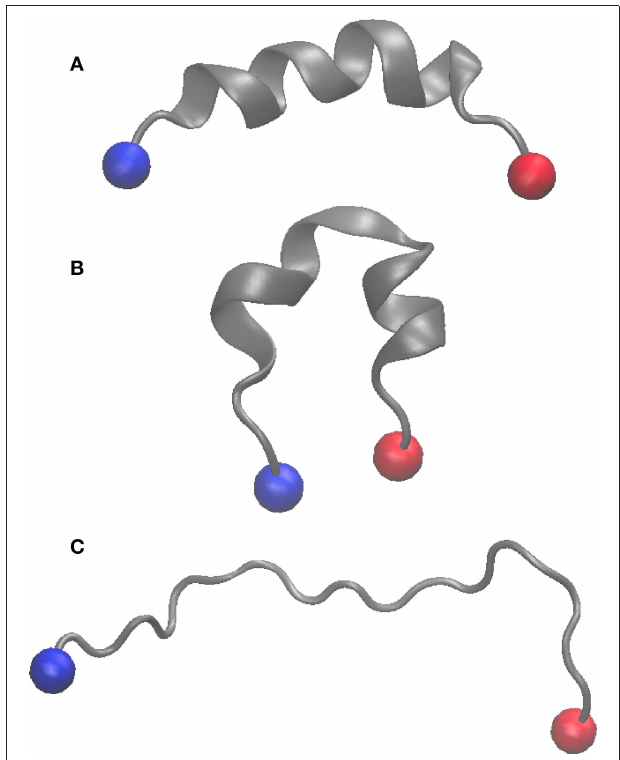
FIGURE 1 | Cartoon representation of the starting structure (PDB ID: 2LD0) (A) , replica with lowest lambda value ( λ = 0.85) in the WT peptide (B) , and that with the highest lambda value ( λ = 1.10) (C) . The N and C termini are shown as blue and red spheres, respectively.